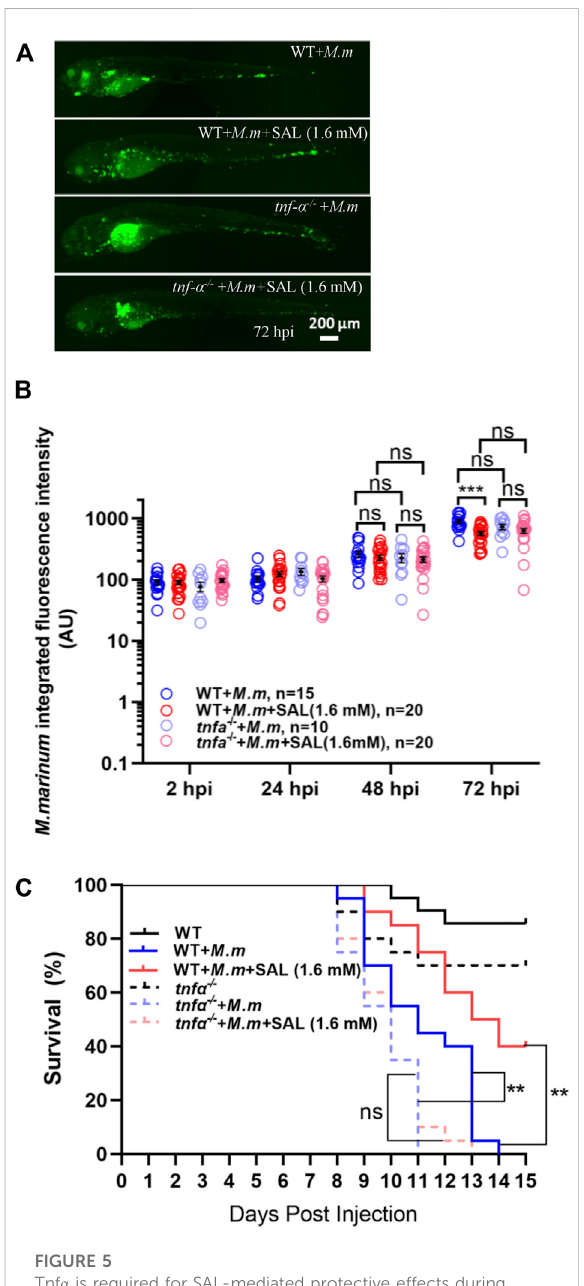
FIGURE 5 Tnf α is required for SAL-mediated protective effects